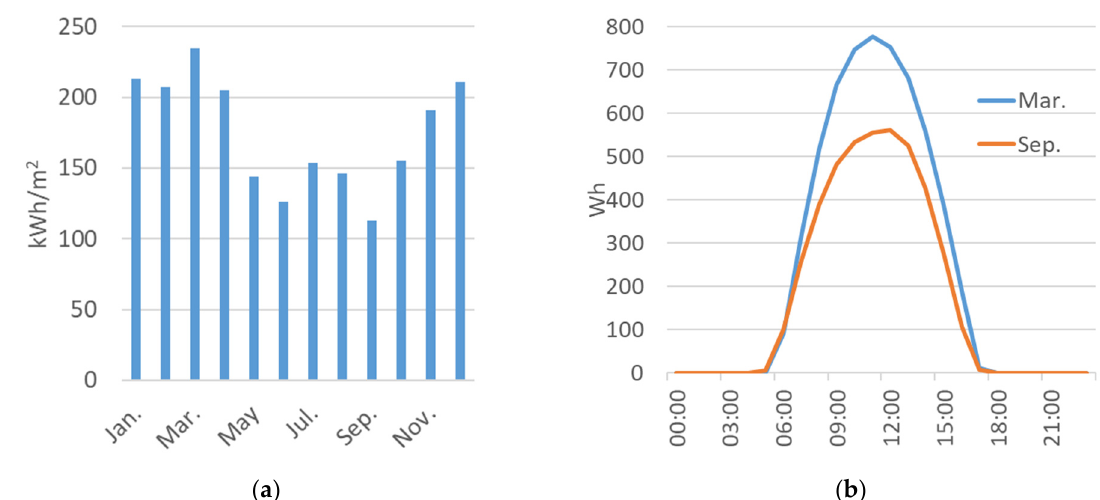
Figure 10. Solar Resource in Tlamacazapa: ( a ) Average monthly solar irradiation; ( b ) hourly generation from 1 kWp PV in March and September [27].